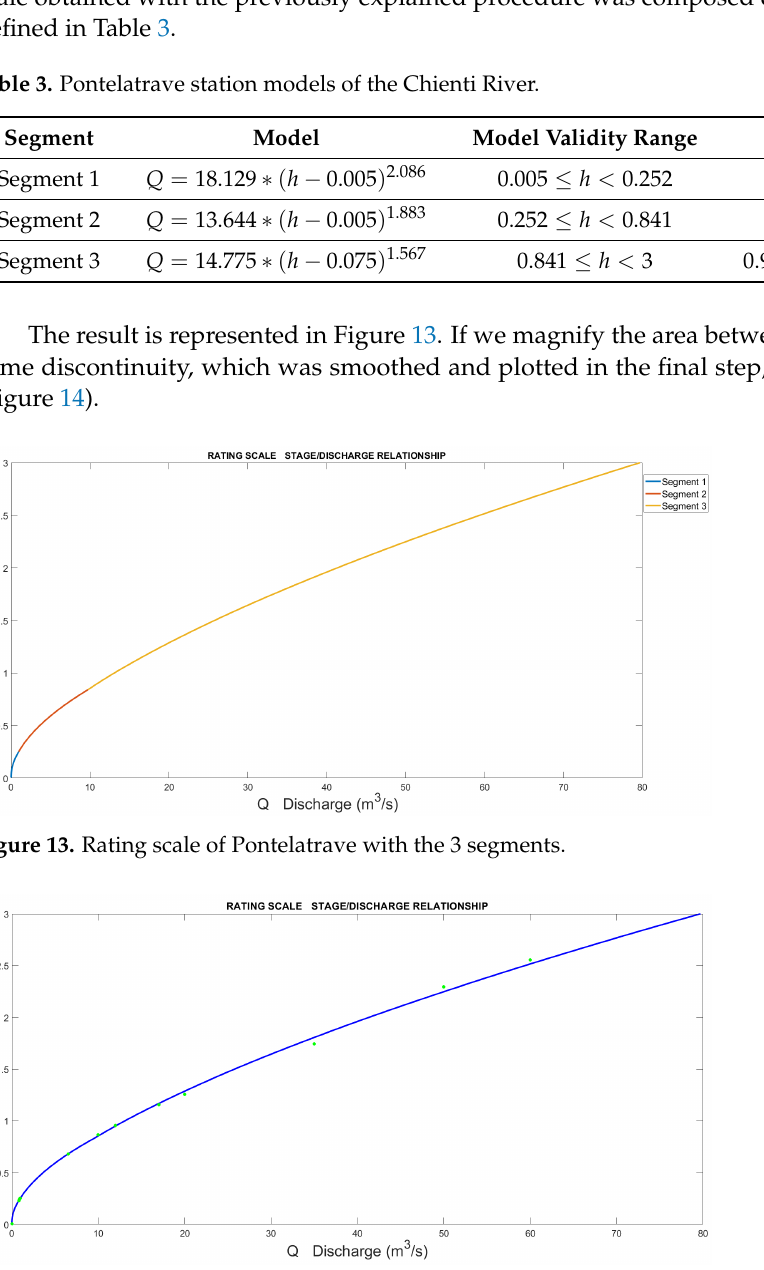
Figure 14. Complete rating scale of Pontelatrave with all the input points used for